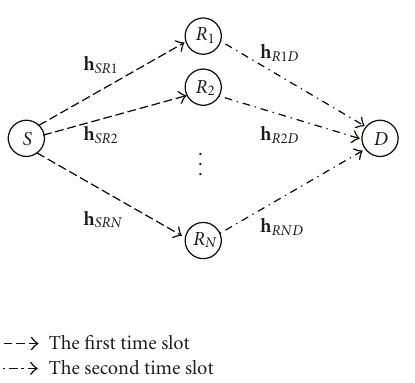
Figure 1: Multiple AF-relays-assisted cooperative diversity